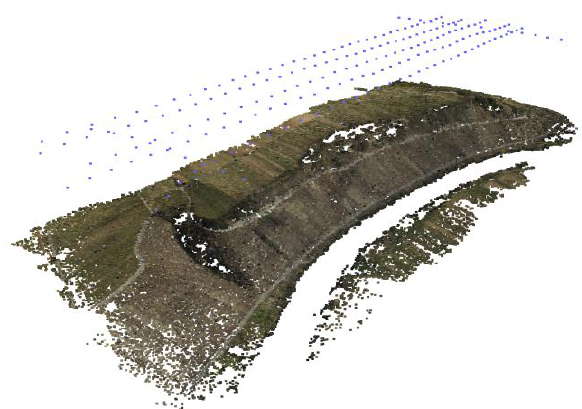
Figure 4: Tie points and cameras station as reconstructed from implemented SaM